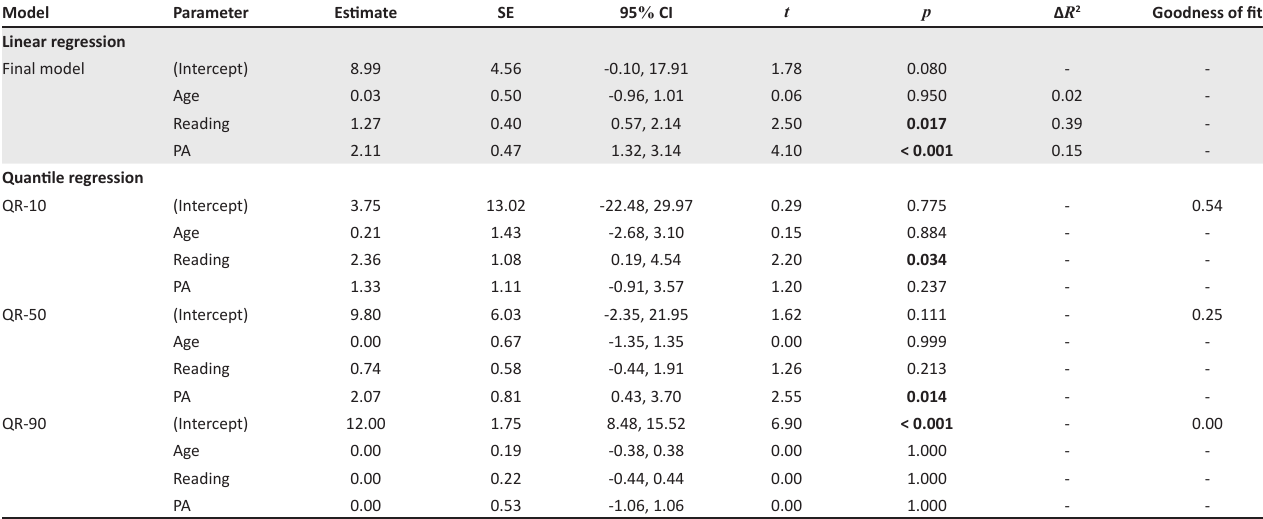
TABLE 2: Study 1: Results of linear and quantile regressions of spelling predicted by age, reading and phonological awareness. Model Parameter